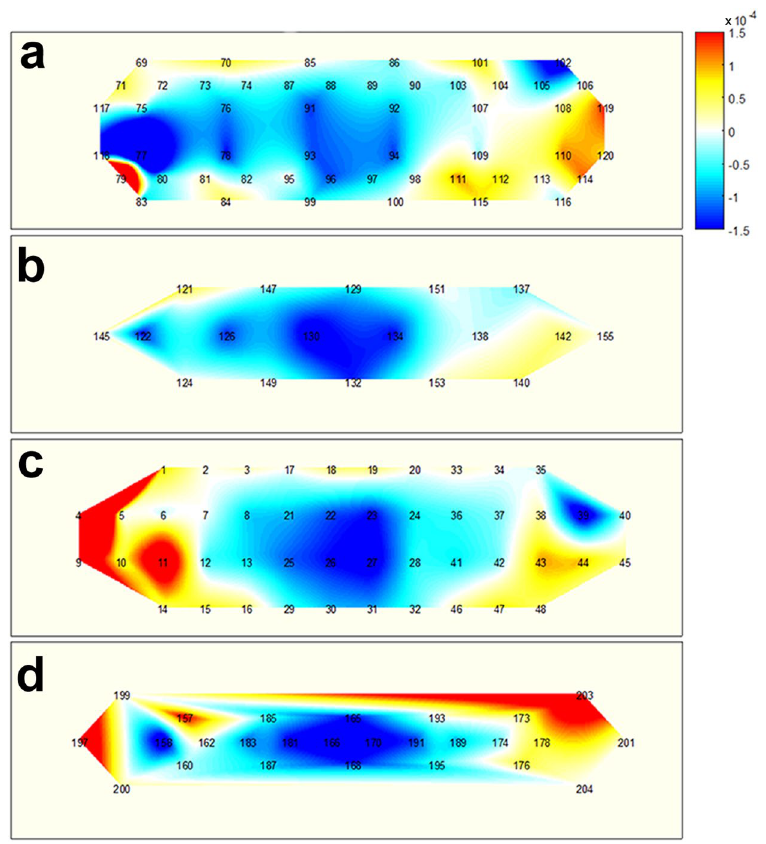
Figure 4. Hemodynamic variations ( Δ HbO) induced by MA and measured by using four SD separations 15 s after task onset: ( a ) 15 mm, ( b ) 21.2 mm, ( c ) 30 mm, and ( d ) 33.5 mm. The numbers in each subfigure denote the locations of NIRS channels. The vertical colour bar indicates the range in